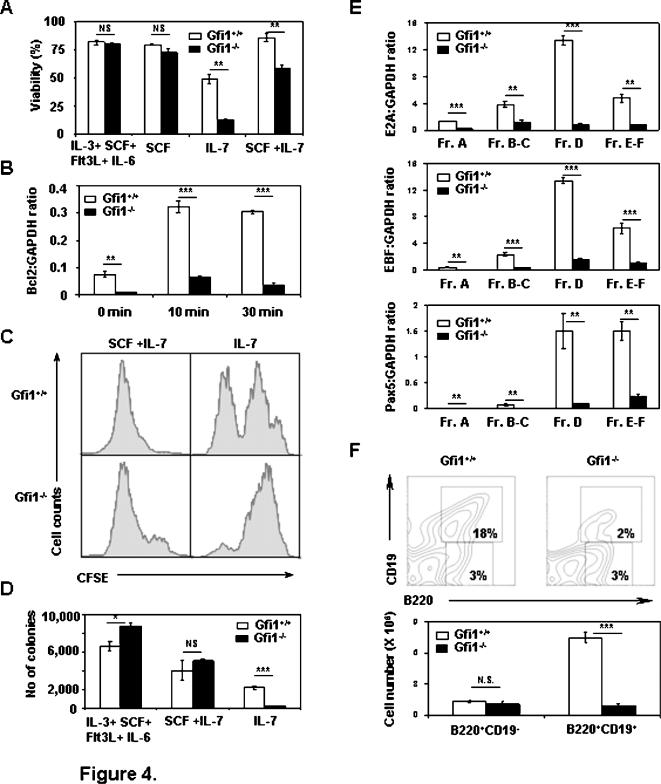
Defective IL7Rα signalling in Gfi1−/− progenitor cells.A) Viability of HSC in response to hematopoietic growth factors. LSK cells from Gfi1+/+ and Gfi1−/− mice were initially cultured in the presence of SCF, IL6, IL3, TPO and Flt3L for 48 hours and subsequently cultured in the presence of indicated cytokines. Cells were analyzed by PI staining and FACS 48 hours later. Shown are the mean values of duplicate samples. Data are representative of 2 independent experiments. B) Realtime PCR showing Bcl2 RNA levels. Sorted Lin−B220+ bone marrow cells were stimulated with IL7. RNA was extracted at indicated time points and reverse transcribed into cDNA. Shown are the mean values of duplicate samples. Data are representative of 2 independent experiments. C) Cell proliferation indicated by CSFE dilution. LSK cells from Gfi1+/+ and Gfi1−/− mice were initially cultured in the presence of SCF, IL6, IL3, TPO and Flt3L for 48 hours. Cells were washed, labeled with CSFE and incubated in the presence of indicated cytokines for 72 hours. Histograms representing CFSE fluorescence and division history of Gfi1+/+ (top panel) and Gfi1−/− (bottom panel) cells are shown. Data are representative of 2 independent experiments. D) CFU assay indicating decreased colony-forming-activity in Gfi1−/− HSC. LSK cells were cultured on semisolid medium in the presence of indicated cytokines. 14 days later, the absolute numbers of colony forming units of Gfi1+/+ (white bars) and Gfi1−/− (black bars) cells were enumerated and plotted. Data are representative of 2 independent experiments. E) Expression of B cell specific transcription factors in defined precursor B cell populations according to Hardy classification. mRNA expression levels of E2A (top panel) EBF (middle panel) Pax5 (bottom panel) were determined by RT-PCR. Shown are the mean values of duplicate samples. Data are representative of 2 independent experiments. F) Contour plots indicating reduced expression of CD19 in Gfi1−/− bone marrow B lineage cells (upper panels). Bar diagrams indicating absolute numbers of CD19+ cells in BM of Gfi1−/− and Gfi1+/+ mice (lower panel, n = 3 mice). Data are representative of 6 independent experiments.